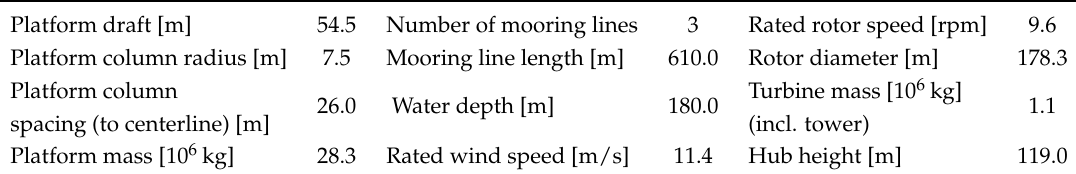
Table 1. TripleSpar Platform Main